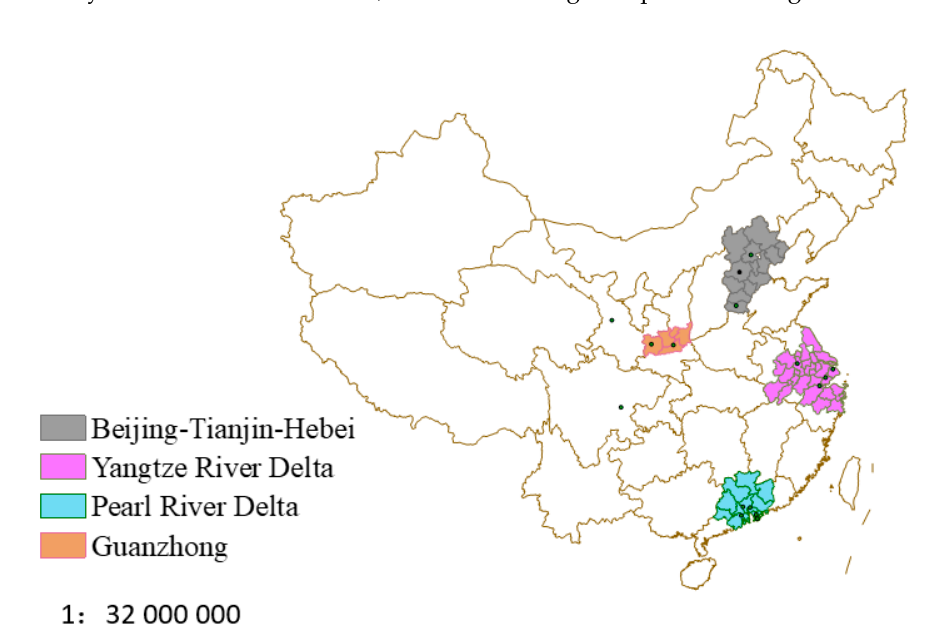
Figure 1. Locations of the Beijing-Tianjin-Hebei (BTH), Guanzhong (GZ), Yangtze River Delta region, (YRD), and Pearl River Delta region (PRD) regions. The map scale is 1:32,000,000.